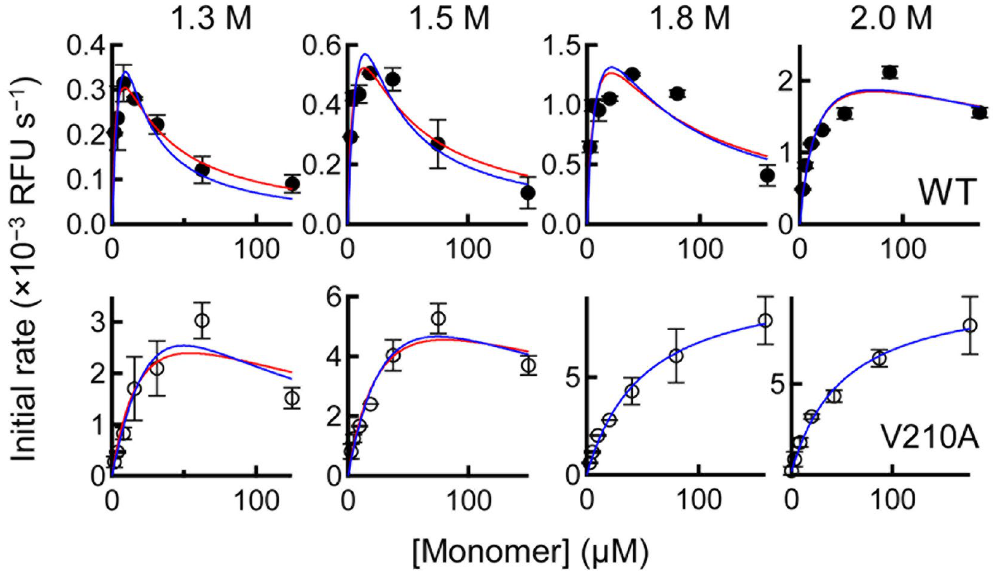
Figure 4. Effects of varying the concentration of the N and U state on amyloid growth. Initial rates of amyloid growth as a function of total concentration of monomers (WT [top row] and V210A [bottom row]. The growth reaction was seeded with 2.5% of WT amyloid. The solid lines are least-squares fits to Equation 3 (red, uncompetitive inhibition) or 4 (blue, noncompetitive